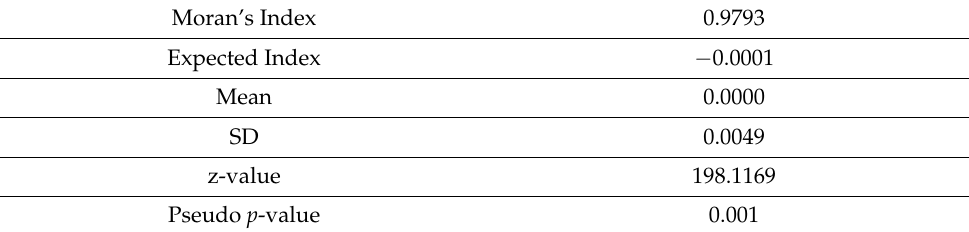
Figure 7. Global Moran’s I summary. Table 3. Moran’s I test